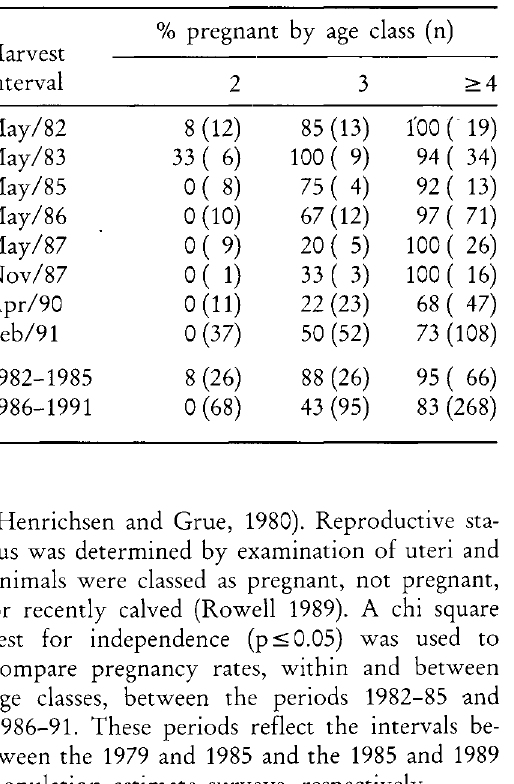
Table 1. Percentage of Banks Island muskox that cal ved or were pregnant, 1982 -